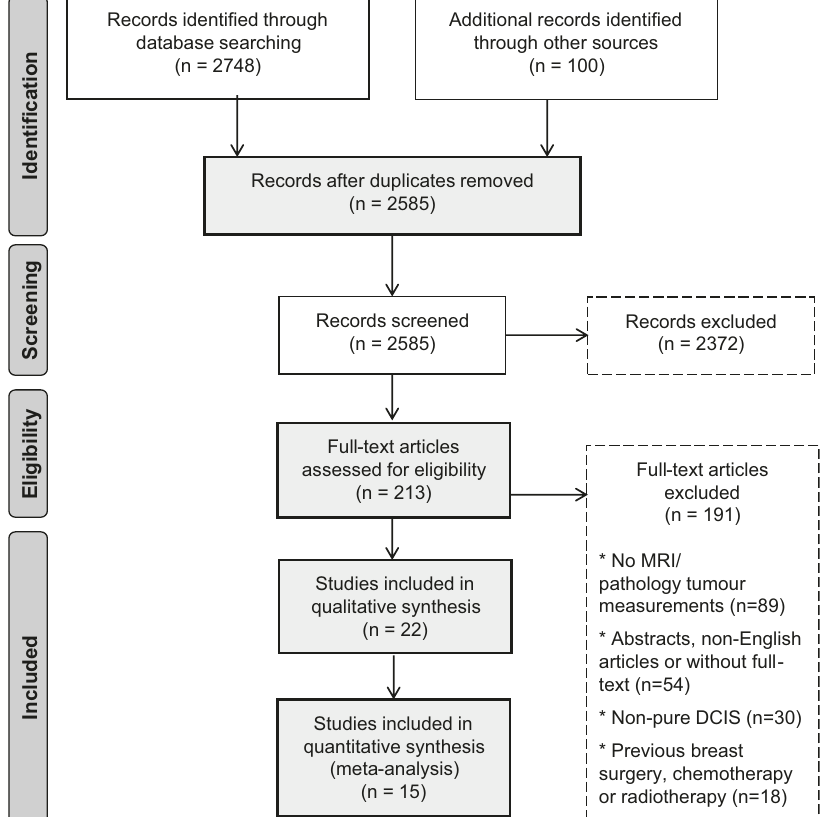
Fig. 1 Flow diagram of studies selection methodology, according to PRISMA fl ow chart 9 . References were selected from the databases applying the search equation and then selected by relevance of title and abstract. Final selection relied in the application of inclusion and exclusion